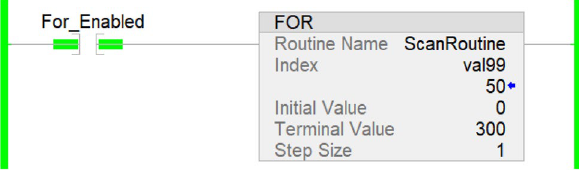
Fig. 8 Embedding a “FOR” to slow the scanning time of the code